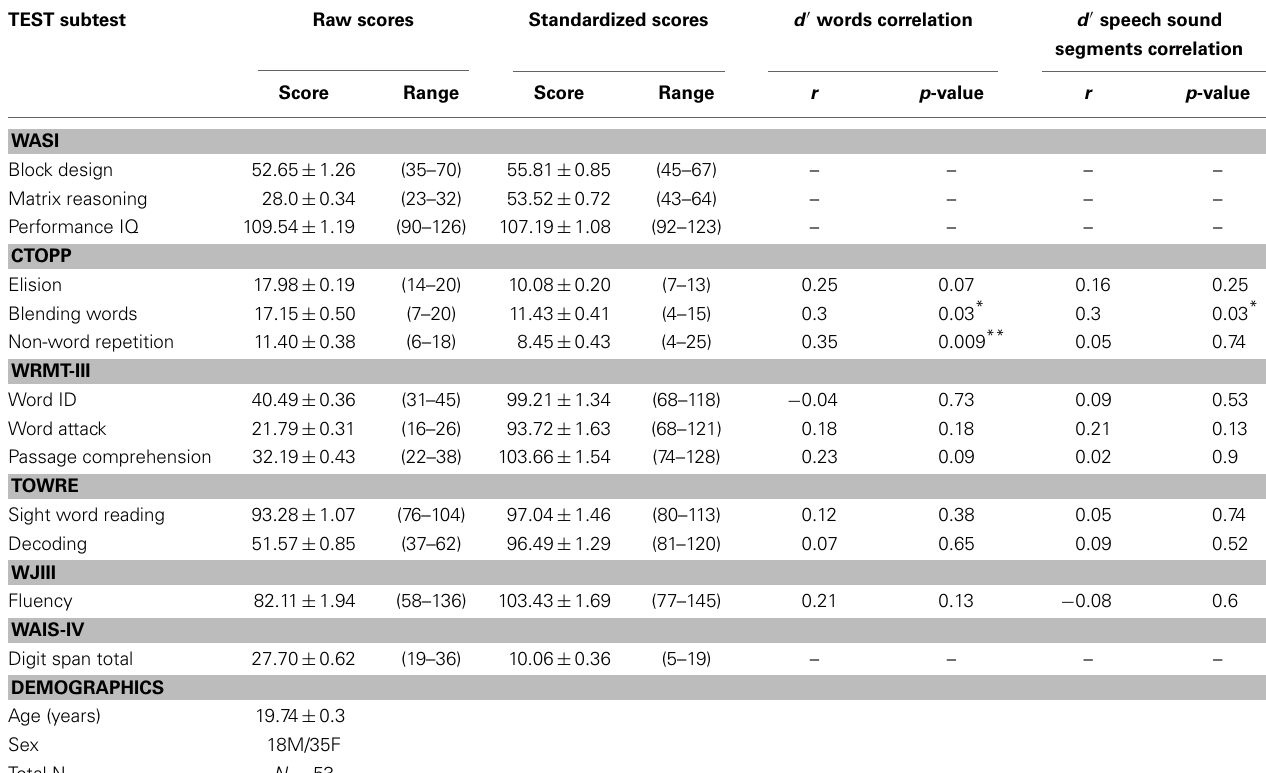
Table 1 | Behavioral assessment